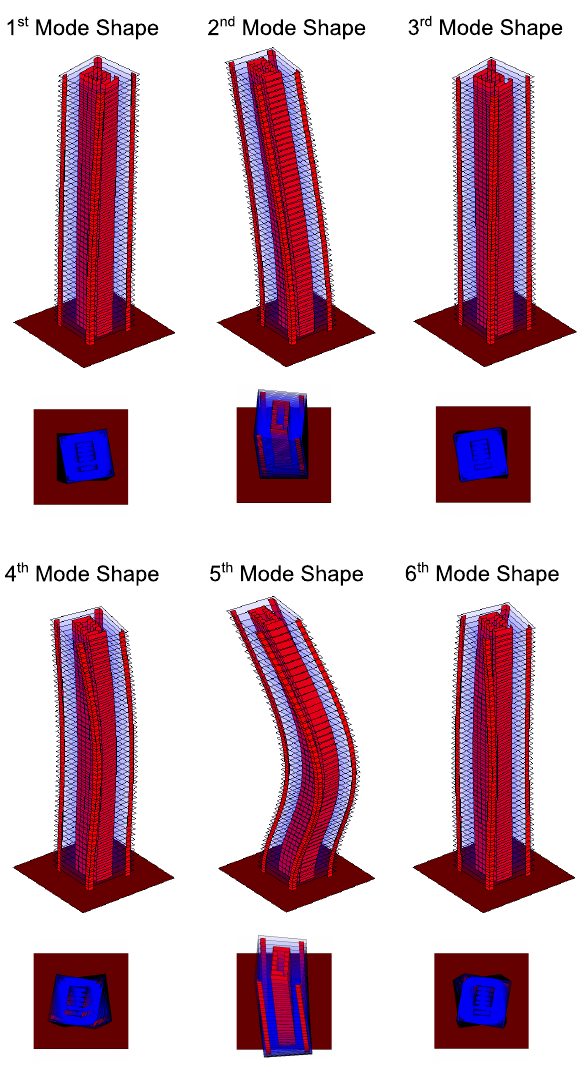
Figure 10: 3D-models and floor plans of the first six analytical